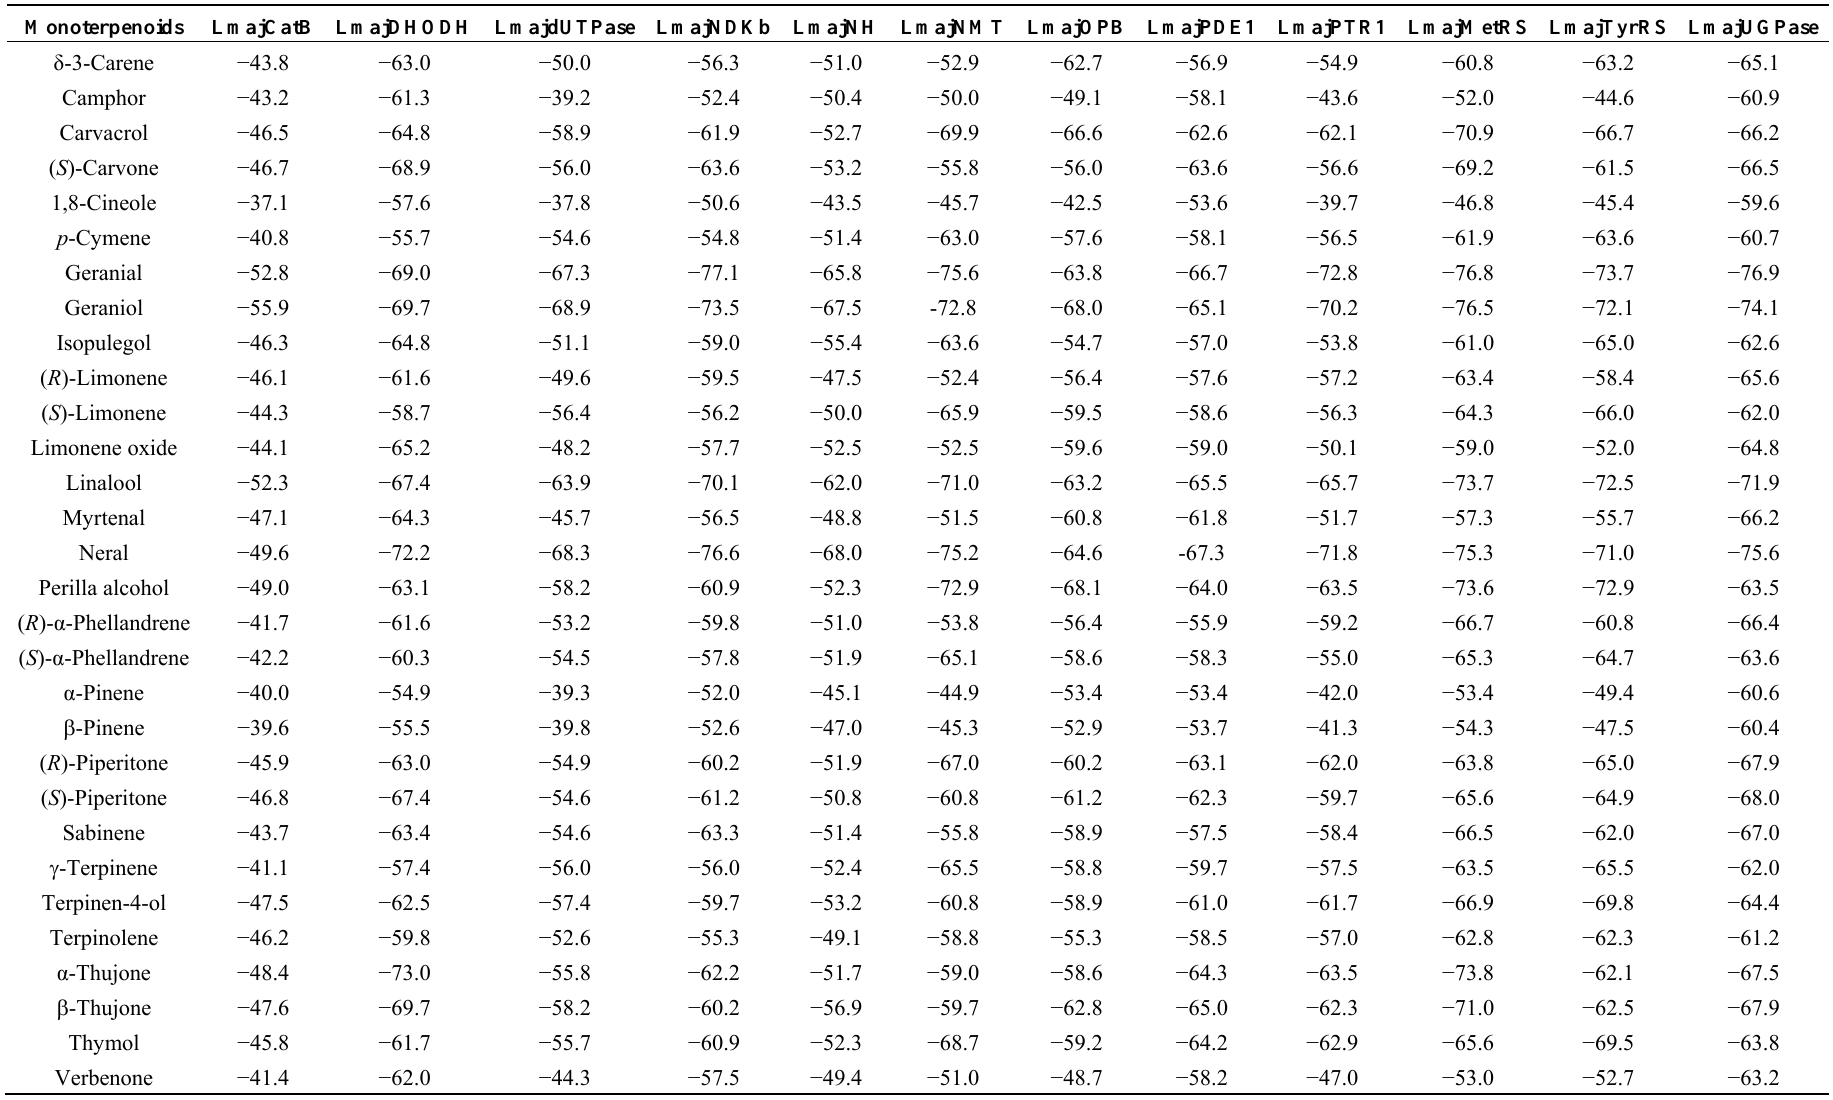
Table 1. MolDock docking energies (kJ/mol) of monoterpenoids with Leishmania major protein